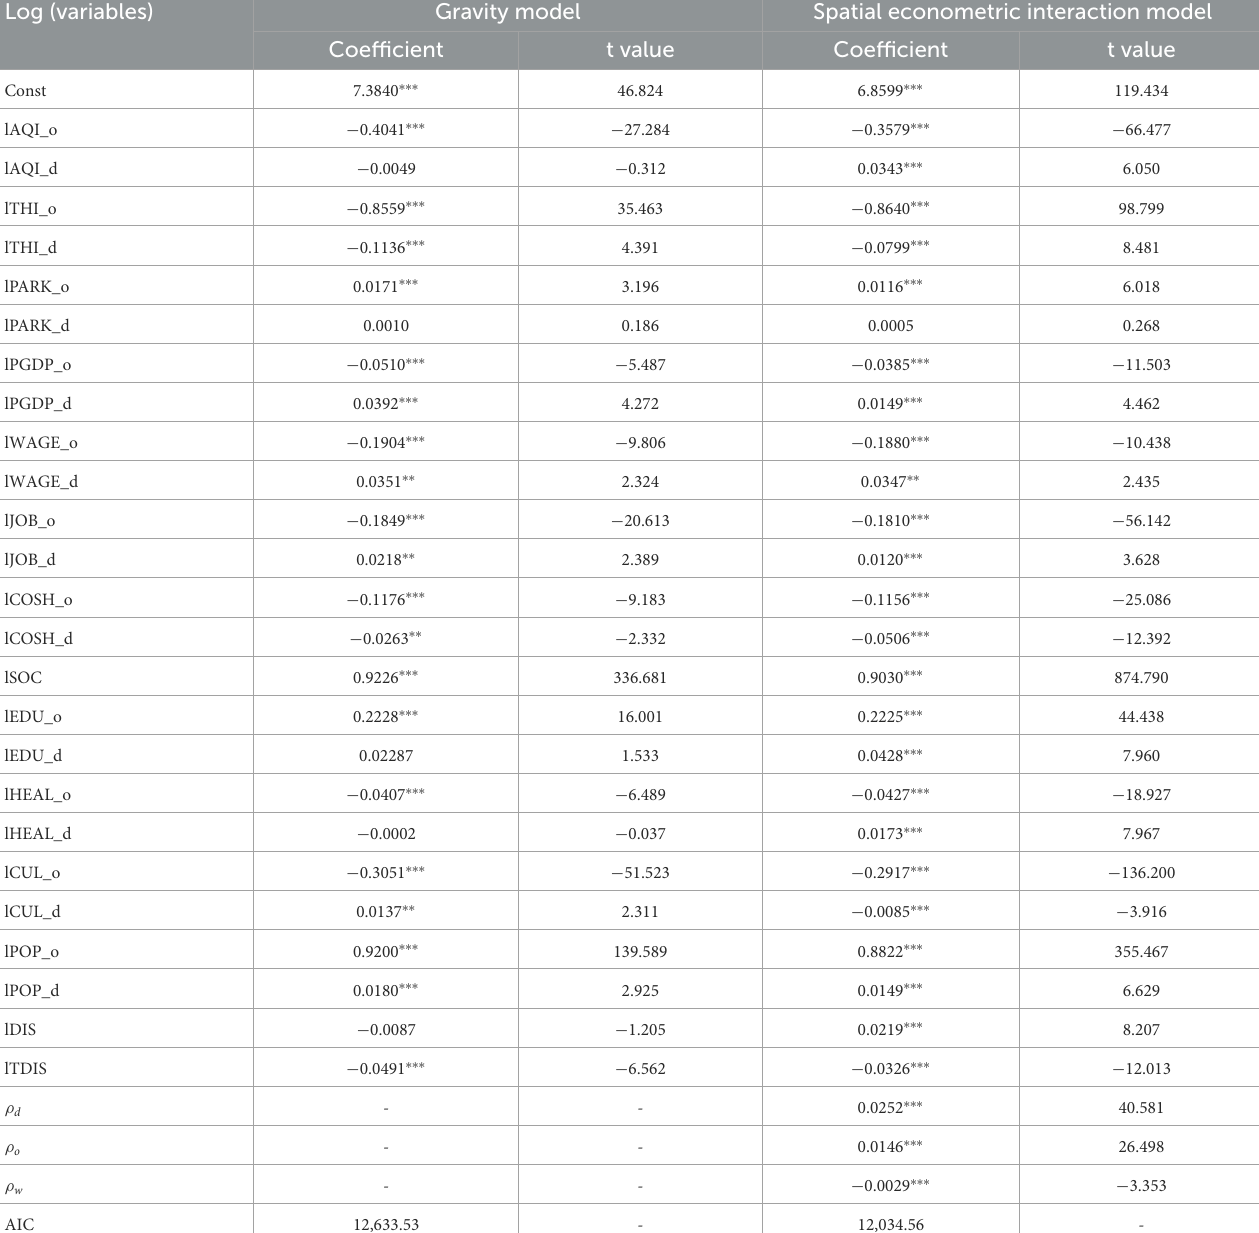
TABLE 3 The estimation results of gravity model and spatial econometric interaction model. Log